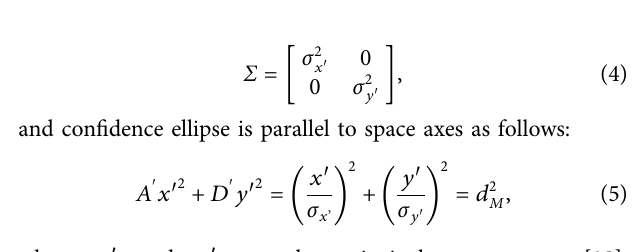
Frontiers in Physics |